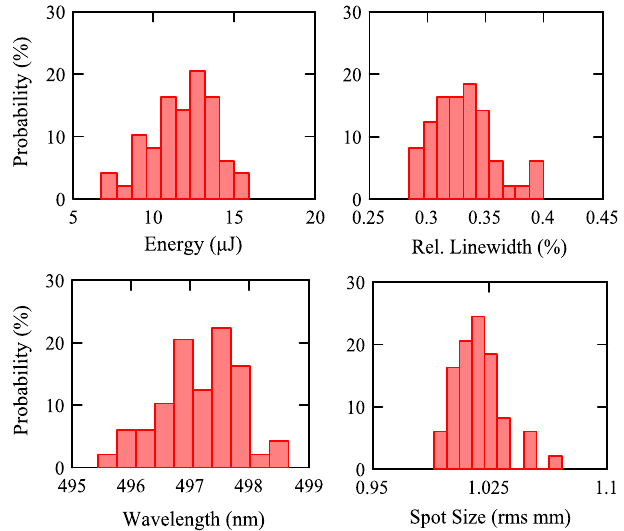
FIG. 12. Histograms of radiation pulse energy, wavelength, linewidth, and spot size at the spectrometer slit for a set of 50 events corresponding to the highest energy measured, set (B) in Fig.